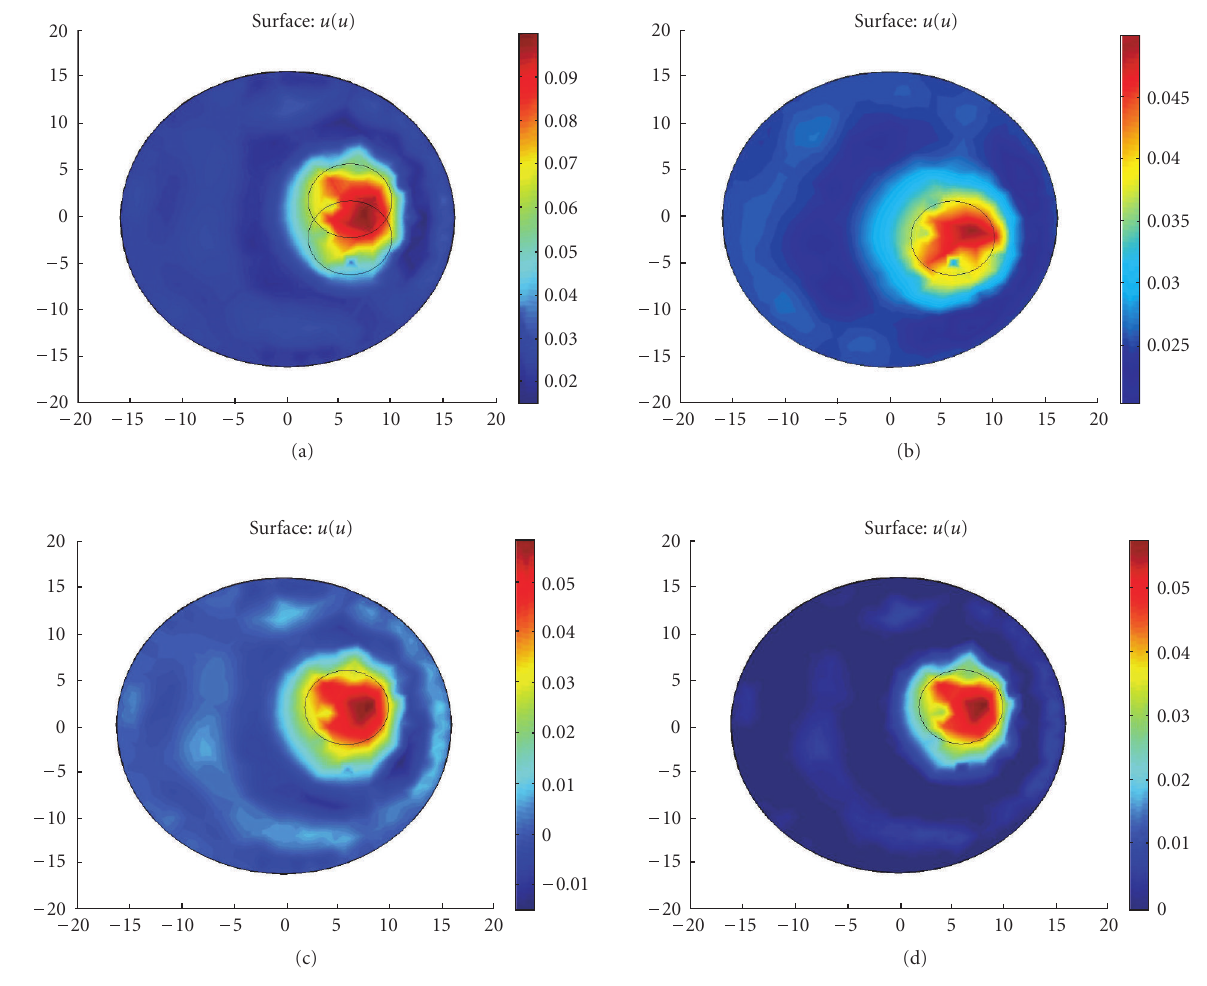
Figure 4: Images reconstructed when FA and HA intersect. (a) and (b) are, respectively, the independent reconstructed images of μ a ( r )+ ε c ( r ) and μ a ( r ). (a) minus (b) educed (c), describing the concentration of fluorochome. (d) constrained the negative values in (c) to zero. The black circles represent the original exact locations and shapes of HA and FA. The original μ a ( r ) is 0 . 05 mm (cid:0) 1 in the lower 8mm-diameter 2) and is 0 . 025 mm (cid:0) 1 in the rest. ε c ( r ) is 0 . 05 mm (cid:0) 1 in the upper 8 mm-diameter circle centred at (6,2) and is zero in circle centred at (6, (cid:0) the rest. Thus, the total absorption in the overlapped part is 0 . 10 mm (cid:0) 1 in